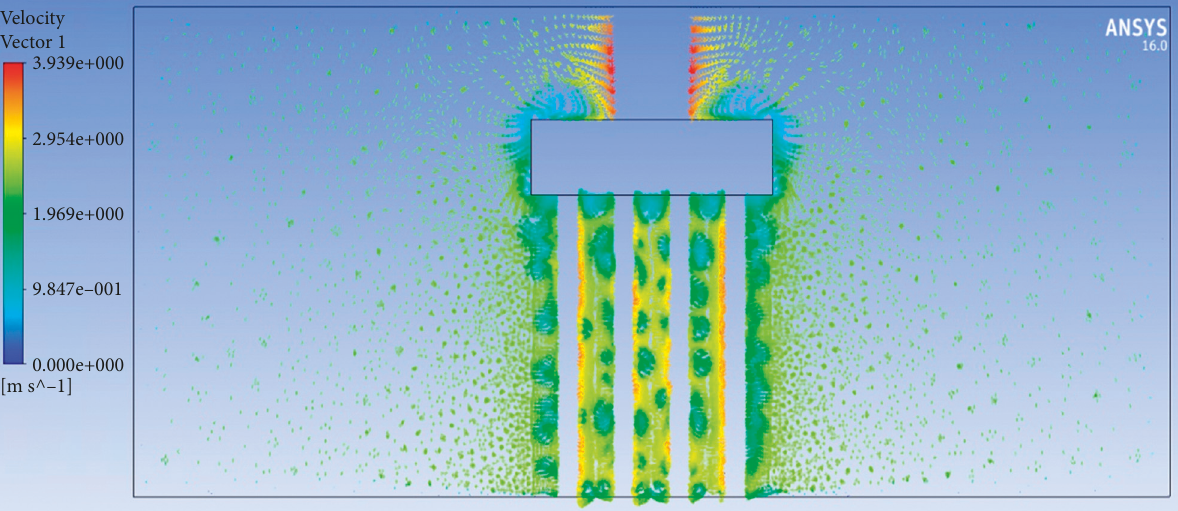
Figure 15: Distribution of flow velocity at the transversal